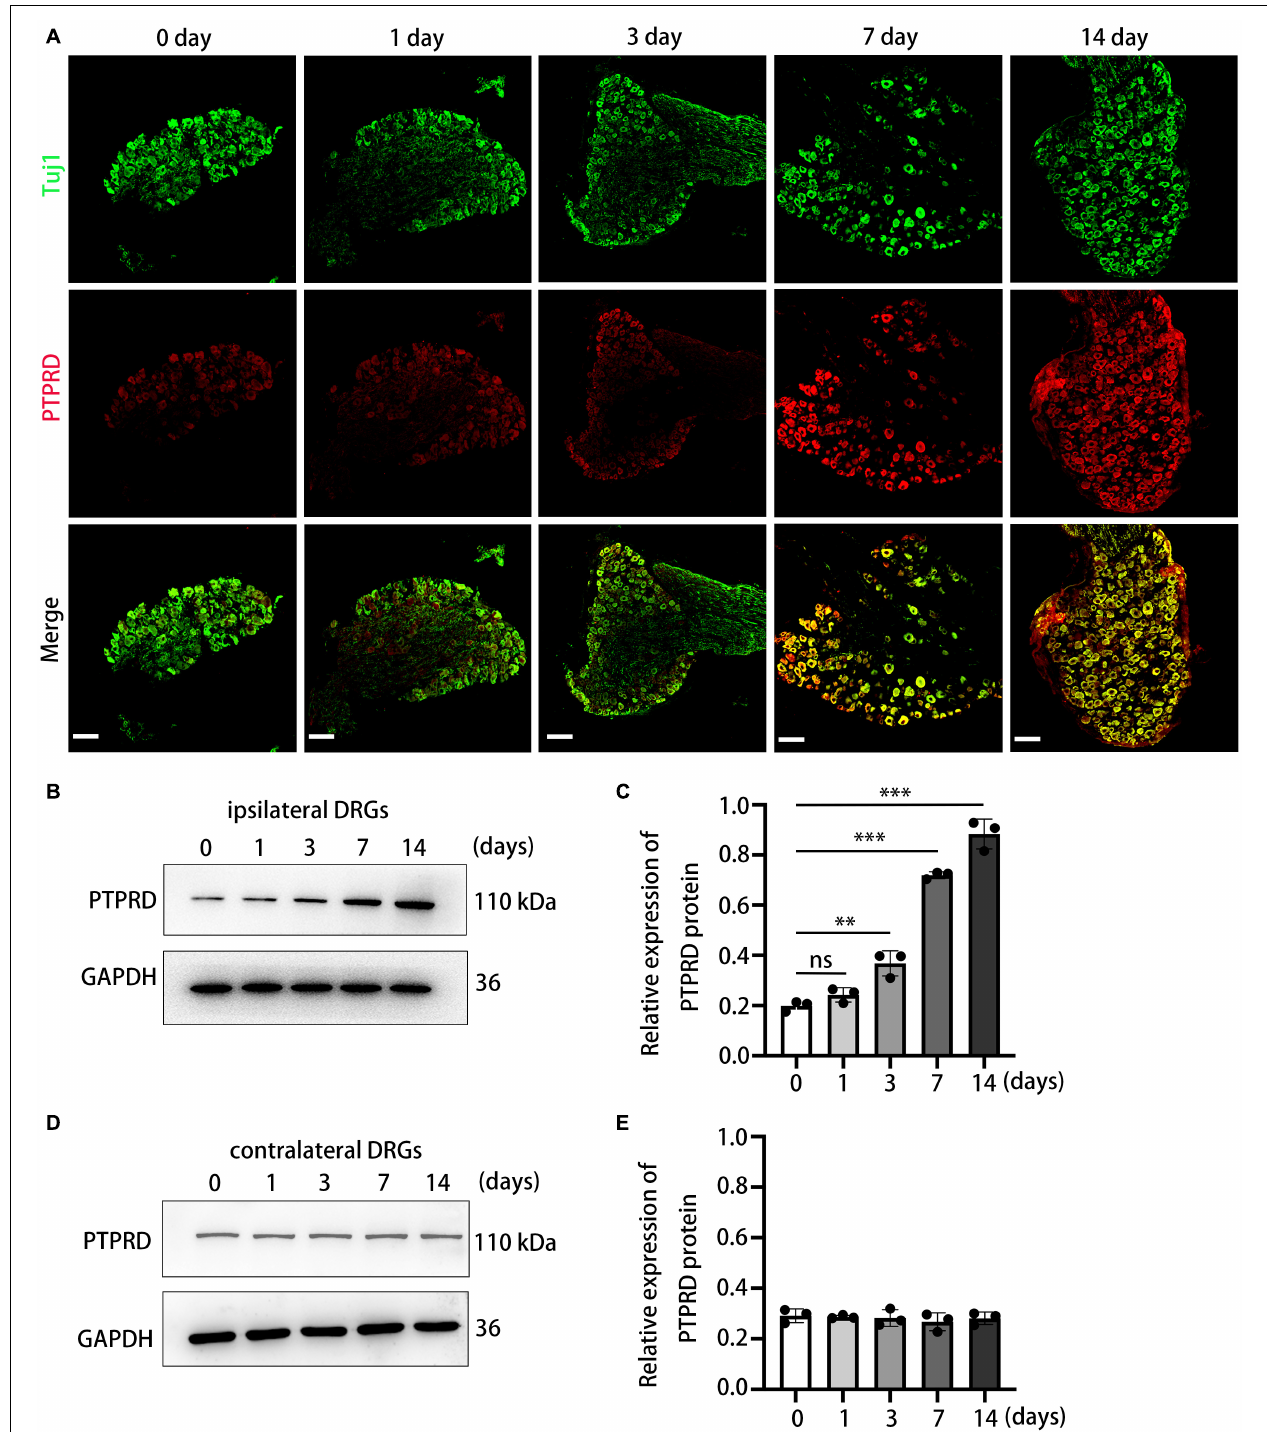
FIGURE 2 | Protein tyrosine phosphatase receptor type D expression levels are increased in the DRG after CCI. (A) Representative images of DRG sections stained for PTPRD (red) and Tuj1 (green) in the indicated groups. Scale bars, 100 µ m. (B) Western blot of PTPRD levels in ipsilateral DRGs (L4–L5) at 0, 1, 3, 7, and 14 days after CCI. Each experiment was repeated three times. (C) Quantitative analysis of data in (B) . N = 3, ∗∗ p < 0.01, ∗∗∗ p < 0.001. (D) Western blot of PTPRD levels in contralateral DRGs (L4–L5) at 0, 1, 3, 7, and 14 days after CCI. Each experiment was repeated three times. (E) Quantitative analysis of data in (D) . N = 3, p > 0.05. Statistical comparisons were performed by unpaired Student’s t -test (C,E)